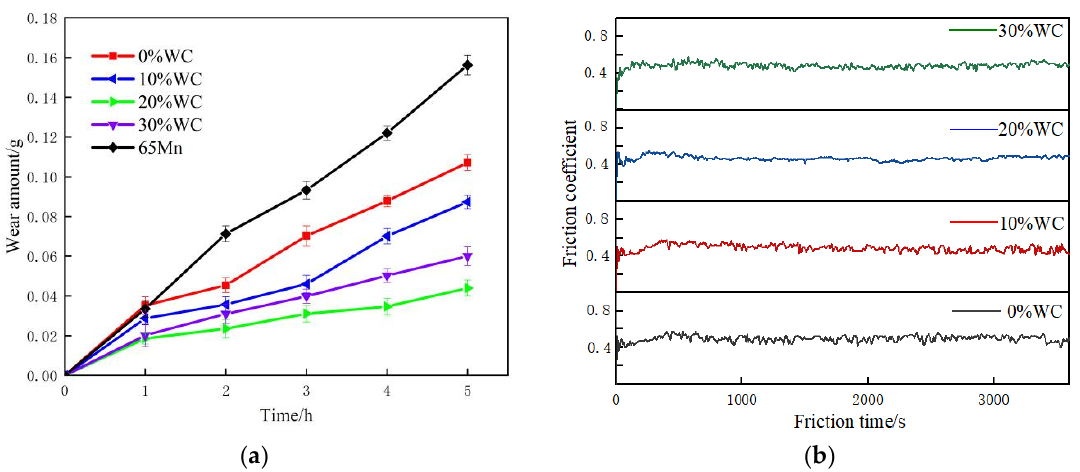
Figure 7. Effect of WC content on wear properties of cladding layer: ( a ) the weight loss of cladding layer; ( b ) the friction coefficient curve of cladding layer. Table 5. Average friction coefficient of HEA cladding layers with different WC content.